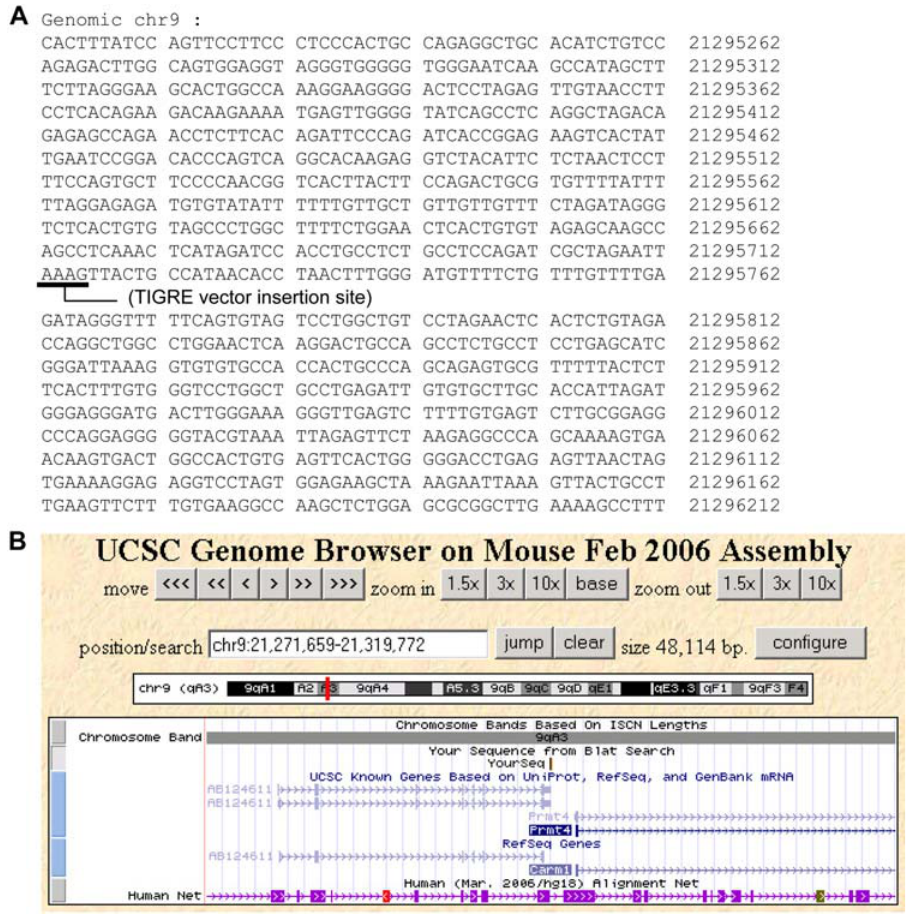
Figure 5. Chromosomal location of the T1 TIGRE locus. (A) Genomic sequences surrounding the T1 TIGRE locus. The underlined AAAG sequence was duplicated upon viral integration and the viral TIGRE vector was inserted exactly in between the duplication. (B) BLAT search of the UCSC Mouse Genome Browser (http://genome.ucsc.edu/cgi-bin/hgBlat) with genomic sequences (as in (A)) surrounding T1 revealed the localization of T1 locus to chr9 qA3. This panel is a screen shot of the BLAT search result. The location of the sequences used for the search is indicated by a vertical bar next to ‘‘YourSeq’’. The insertion site is in between two genes: AB124611 and Carm1 (alternative name Prmt4 ), and does not seem to disrupt either